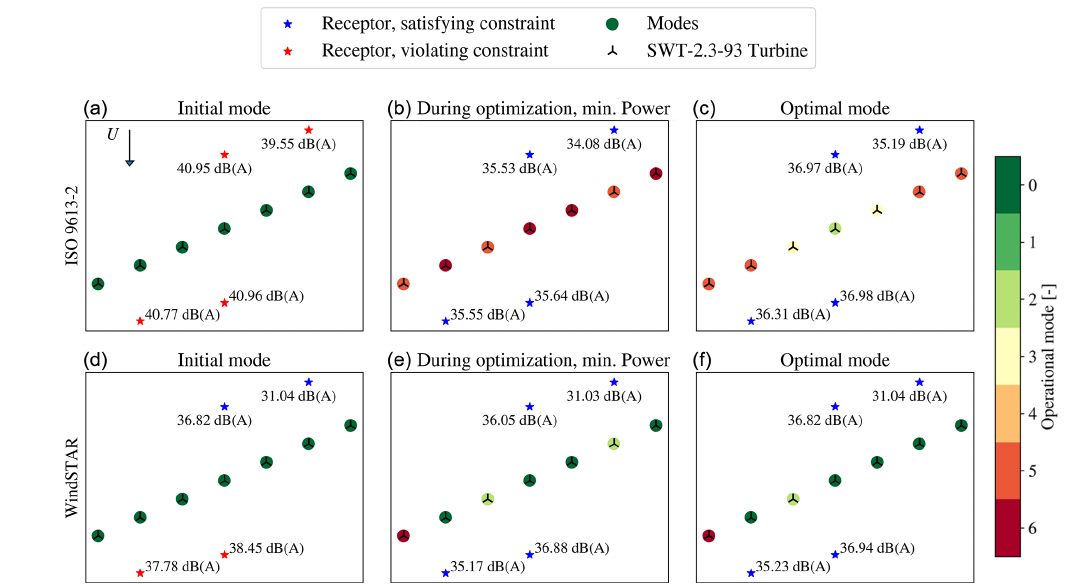
Figure 9. Scatter plots of the operational modes of the seven SWT-2.3-93 wind turbines before (a, d) , at the minimum power iteration during (b, e) and after (c, f) the optimization at θ = 0 ◦ and U hub = 9 . 3ms − 1 . The noise constraint is set to L p , lim ,j =